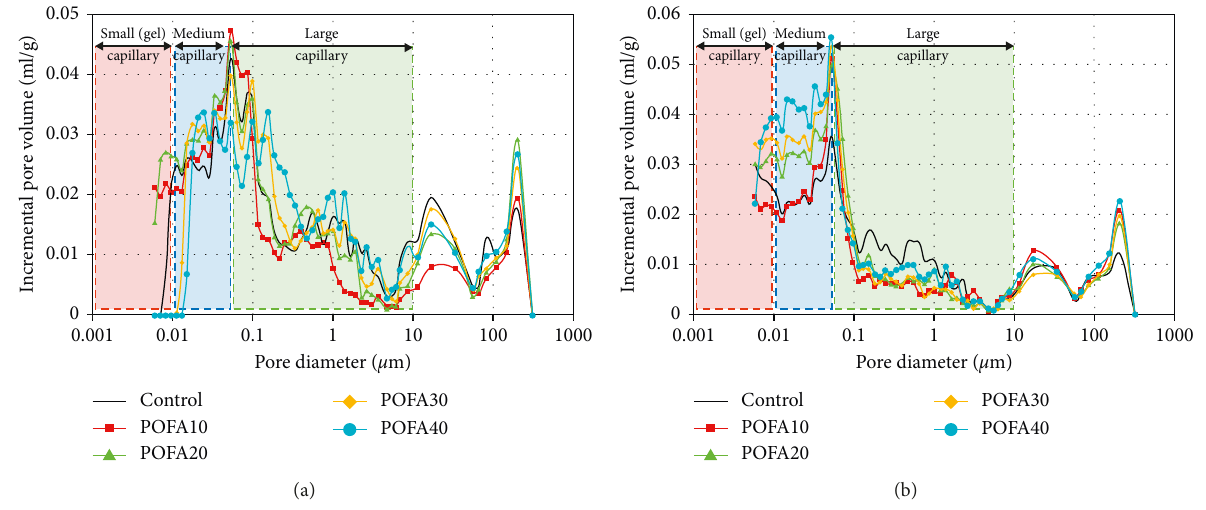
Figure 7: Pore distribution of mortars containing mPOFA aged for (a) 3 and (b) 28